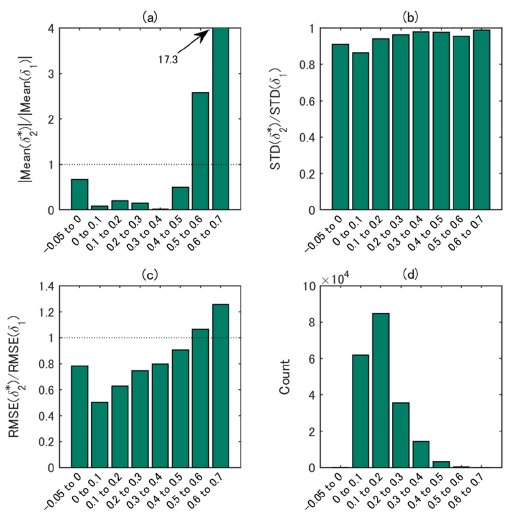
Figure 8. ( a ) Ratio of absolute mean of difference between MODIS EVI minus MODIS-compatible VIIRS EVI ( δ (cid:2870)∗ ) to that between MODIS EVI minus VIIRS EVI ( δ (cid:2869) ) for EVI-dependent data; ( b ) Ratio of STD for δ (cid:2870)∗ to that for δ (cid:2869) ; ( c ) Ratio of RMSE for δ (cid:2870)∗ to that for δ (cid:2869) ; ( d ) Frequency of EVI distribution in data for evaluation.